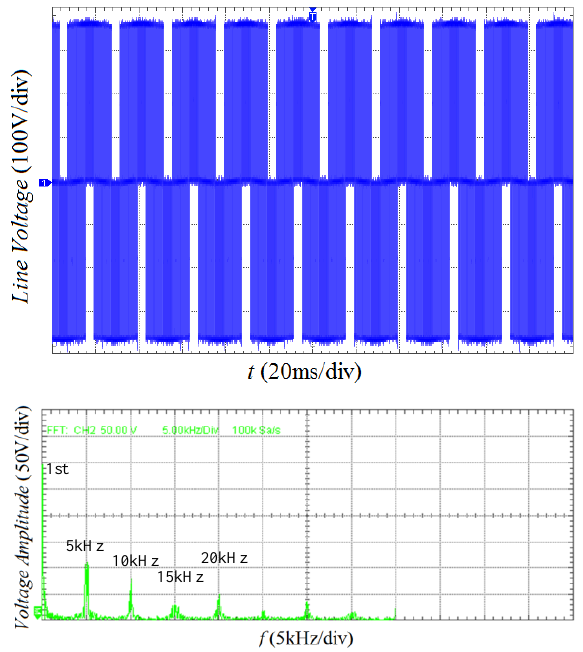
Figure 24. Experimental result of DZIPWM at m = 0.9703: ( top ) line voltage u ab ; ( bottom ) the FFT analysis of u ab .